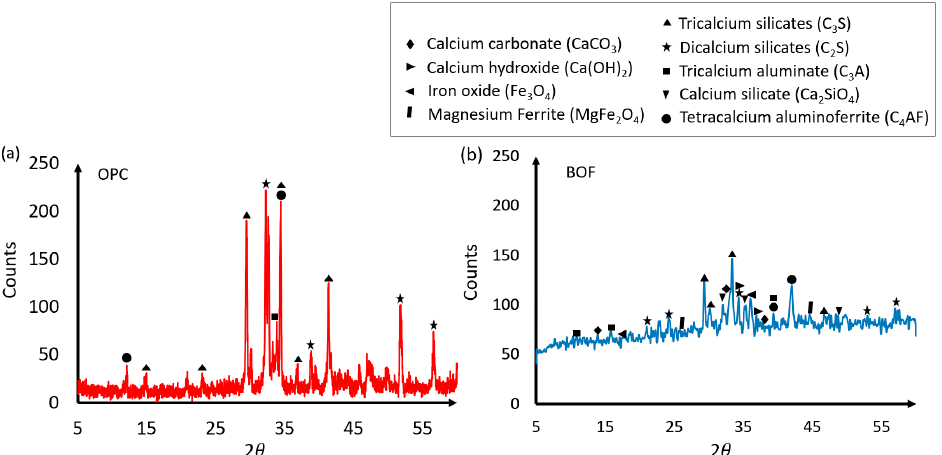
Figure 2. XRD results of ( a ) OPC and ( b ) BOF in the BOF-enhanced cement.